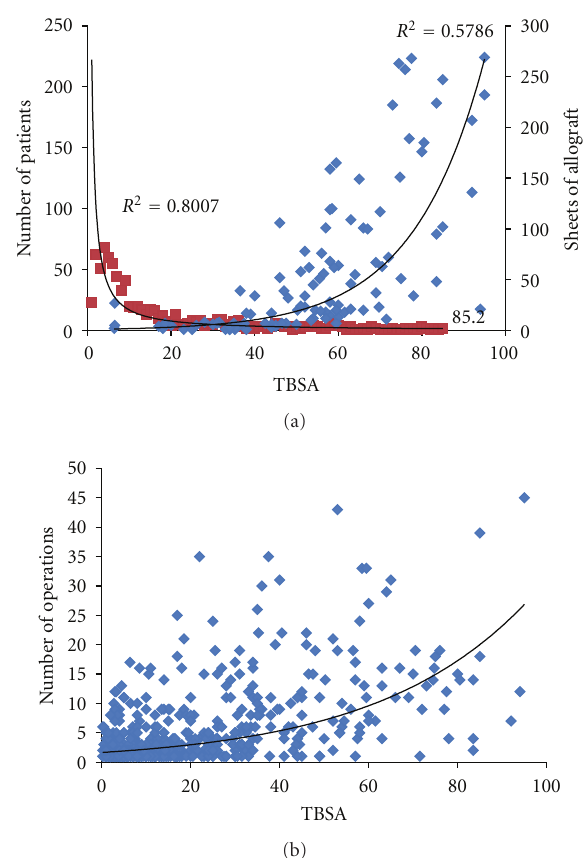
Figure 1: (a) Burn incidence superimposed onto the concurrent use of skin allograft in relation to TBSA. (b) Number of operations performed during the acute burn hospitalization as a function of TBSA. TBSA: total body surface area; CPA: cryo-preserved